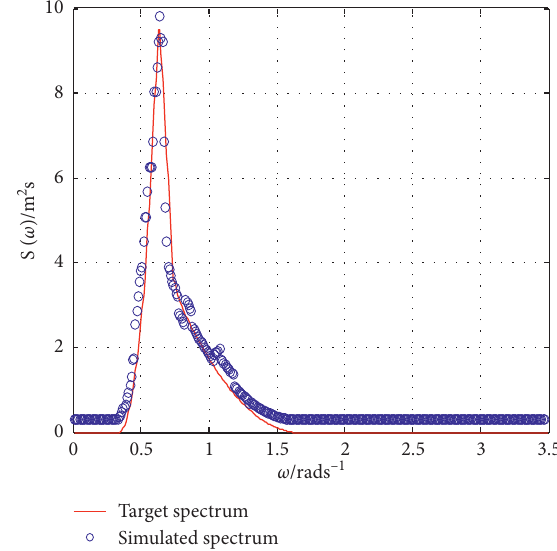
Figure 7: Comparison of the spectral structure of target power spectrum and the spatiotemporal spectrum results of freak